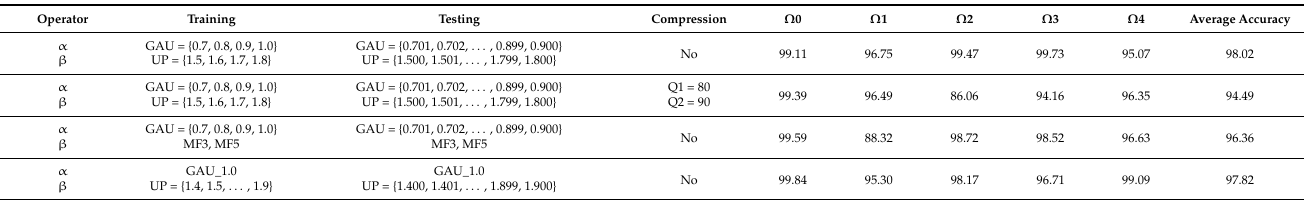
Table 4. Detection for dissimilar operator specifications.